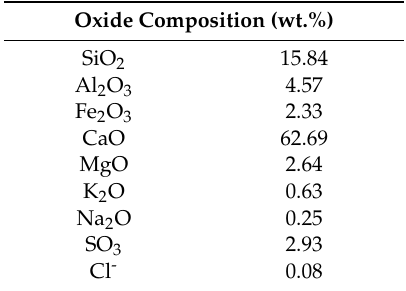
Table 1. Chemical composition and basic material properties of used cement.